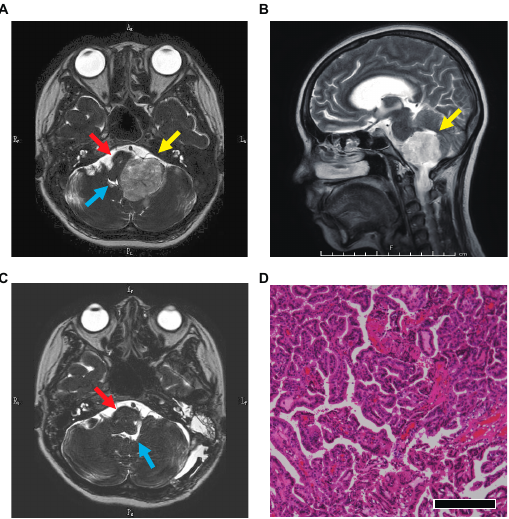
Figure 1. Magnetic resonance imaging of the brain and a specimen of the tumor. Imaging confirmed a mass (yellow arrow) on the left cerebellopontine angle compressing the brainstem (red arrow) and nearly obstructing the fourth ventricle (blue arrow). ( A ) T2-weighted image, horizontal section. ( B ) T2-weighted image, sagittal section. ( C ) T2-weighted image 14 days after the tumor resection, horizontal section. ( D ) A photomicrograph of a surgical specimen showing a papillary structure covered with a single layer of columnar epithelial cells along a narrow interstitium with abundant vessels. Hematoxylin and eosin stain, × 100, with a scale bar of 50 µ